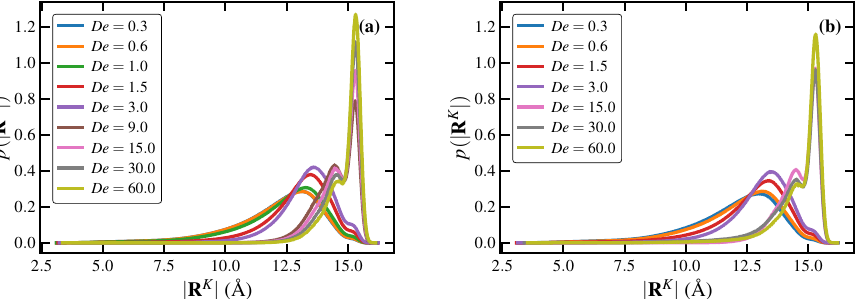
Figure 18. Probability distributions of the magnitude of Kuhn segments, melt under steady-state UEF (panel ( a )) and PEF (panel ( b )) at various De . In Figure 2 at De = 9.0, the mean fractional extension begins to develop a steady-state x value of 0.85 at 2 < ε H < 4 corresponding to a stretched liquid state, followed by (cid:104) (cid:105) ≈ a rapid extension to the final steady-state value of